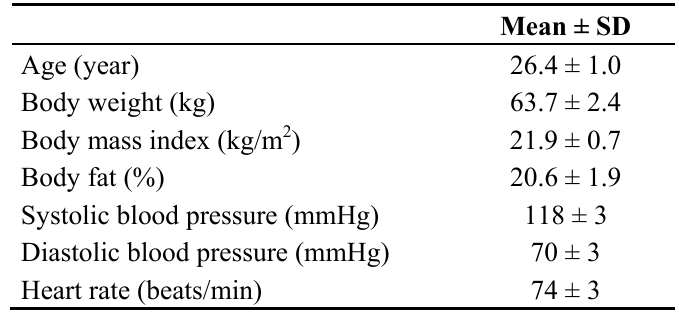
Table 1. Baseline characteristics of the studied participants (mean ±